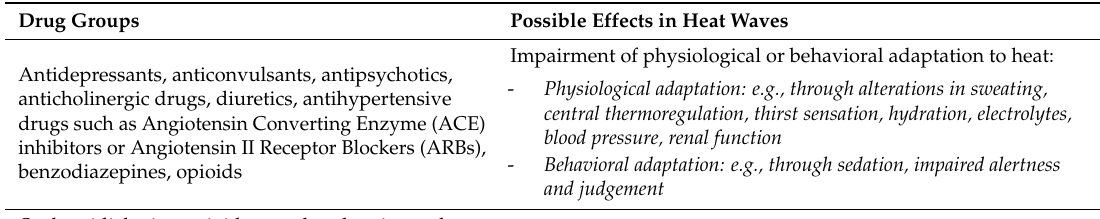
Table 1. Drugs associated with increased risks for heat health impacts (adapted from Westaway et al. [15]). Drug Groups Possible Effects in Heat